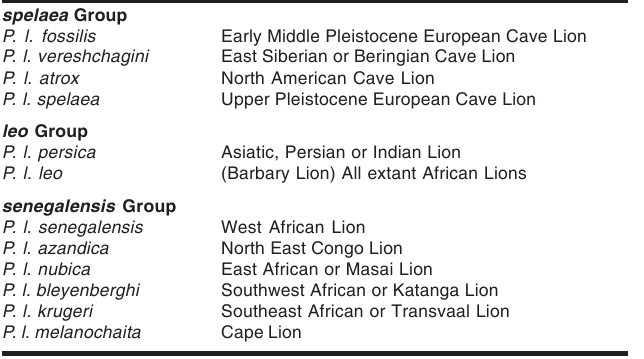
Table 1. Subspecies classification of lions (Burger et al. 2004).